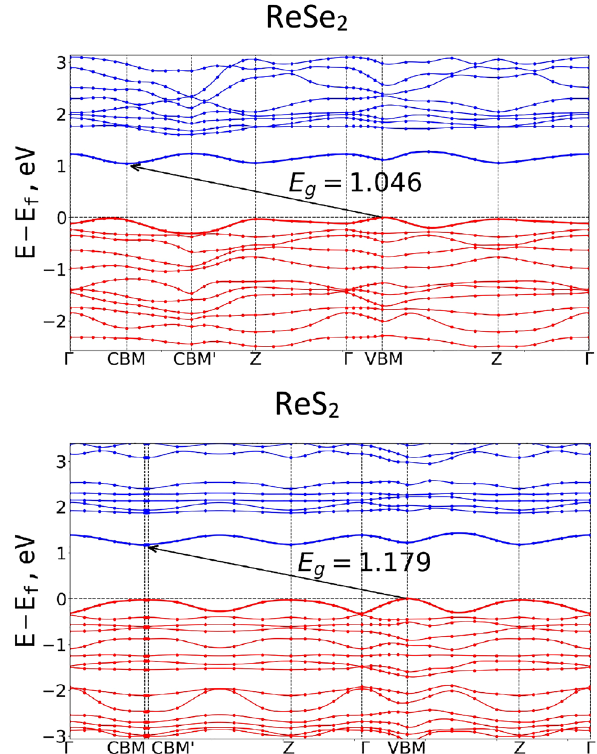
Figure 2: The band structure of the bulk ReSe 2 and ReS 2 calculated bytheGGAlevelof DFTforthepathgoingthrough Γ and Z pointsand the band extrema (CBM and VBM). The Fermi energy is set to zero. The CBM ′ and VBM ′ points are the intersection points of the boundary surface of the BZ and the straight lines connecting the Γ point and CBM or VBM points, respectively. The bands are fl attened inawiderangeofthewavevectors.CBMandVBMpointscorrespond to the different k -values, so this is an indirect semiconductor. CBM, conduction band minimum; VBM, valence band maximum; DFT, density functional